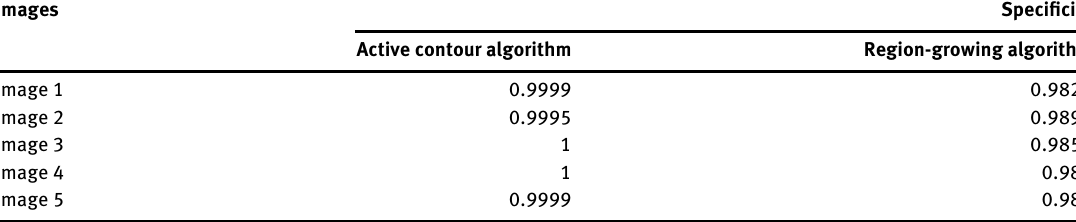
Figure 4: Sensitivity Comparison of the Proposed Segmentation. Table 5: Specificity Comparison of the Proposed Segmentation Method.